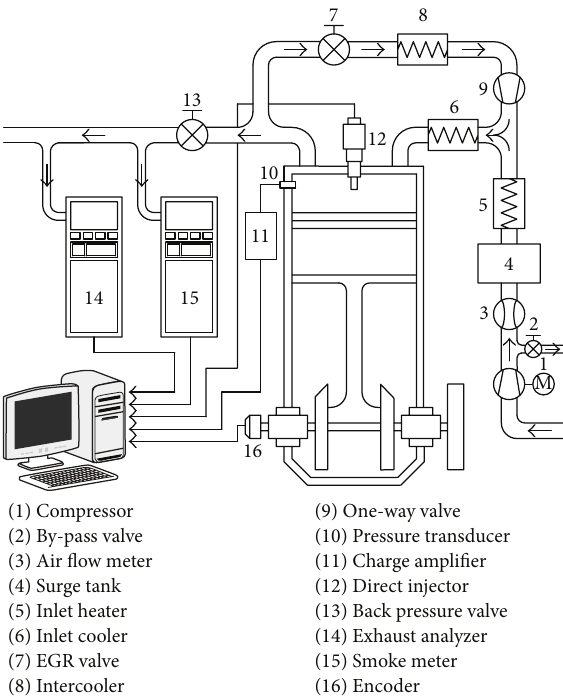
Figure 1: Schematic of experimental